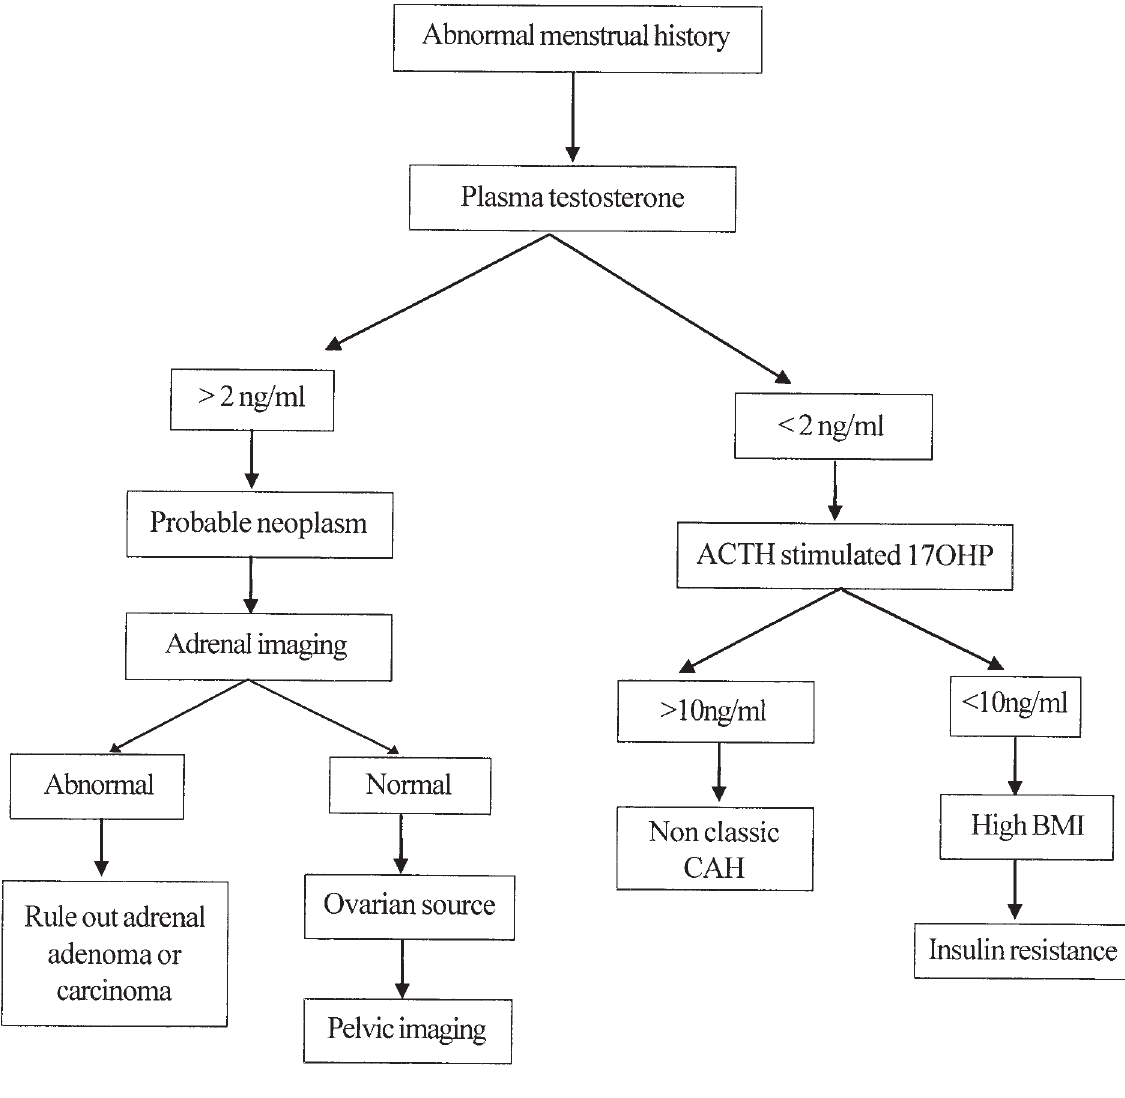
Figure 2. Approach to the diagnosis of hirsutism